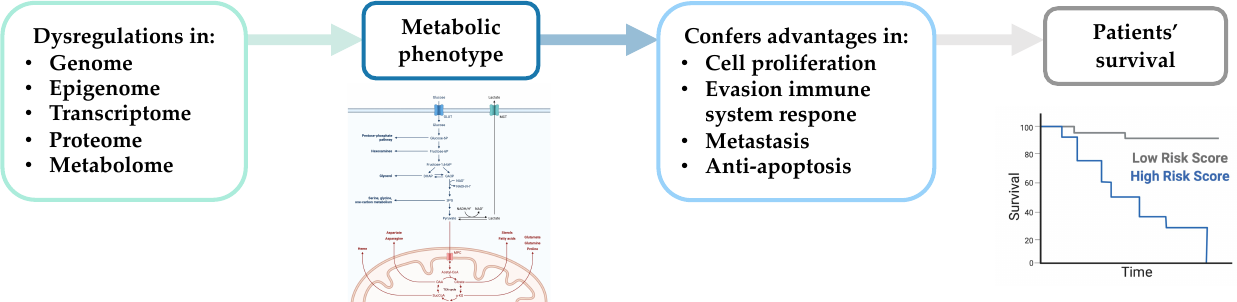
Figure 2. Schematic representation of the impact of metabolic changes on essential molecular processes associated with tumor progression and patient survival. Created with BioRender.com.